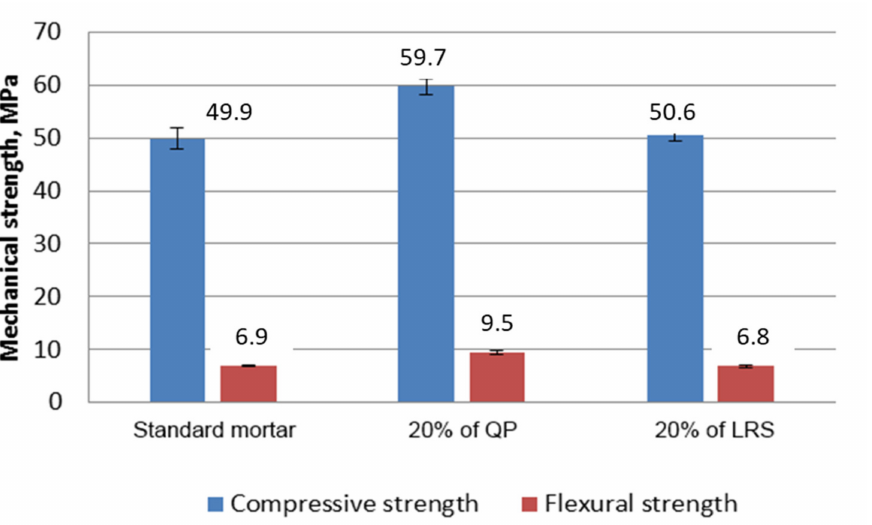
Figure 8. Compressive strength and flexural strength of tested mortars, including standard mortar with CEMI 42.5R and mortars containing 20% of quartz powder (QP) or lunar regolith simulant (LRS) in the total mass of